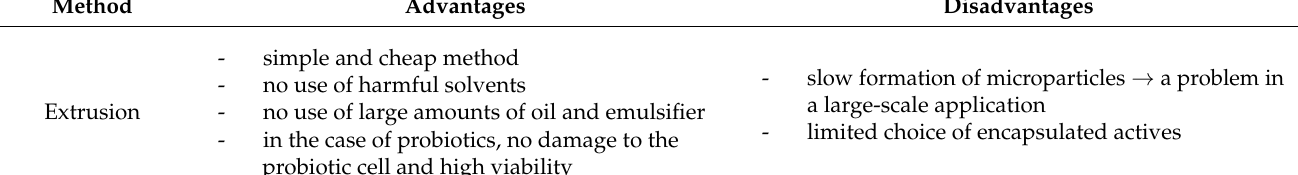
Table 1. Advantages and disadvantages of alginate microencapsulation methods